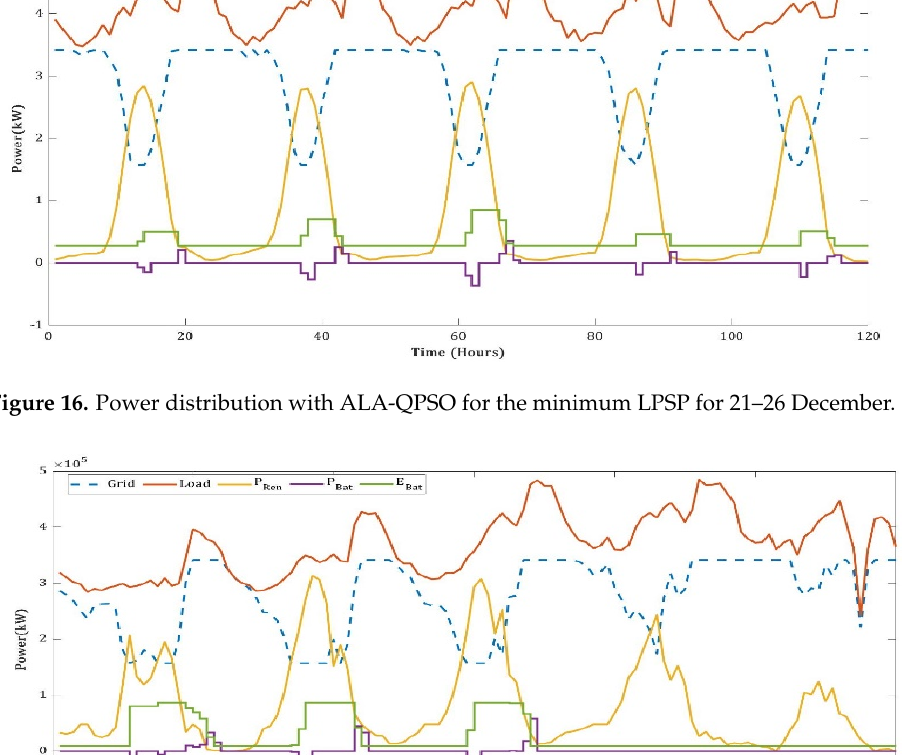
Figure 18. Power distribution with mutation-based ALA-QPSO for the minimum LCoE for 21–26 June. A sensitivity analysis is performed on the results obtained through ALA-QPSO. In the first scenario, it is assumed that there is 50% damage to the BESS. The power distri- bution with this scenario is shown in Figure 19 for June. It can be observed that the de- mand response is enforced during peak hours. It should be noted that the LCoE has in- creased drastically to 0.1372 USD, which is 73% more. In addition, the LPSP has increased to 1.62%. We conclude that preventive maintenance is necessary to avoid any load loss due to BESS reduction. Another sensitivity analysis is performed for 20% demand ap- preciation and 20% BESS reduction. The results for the same are shown in Figure 20. It is observed that due to the rise in demand, ramping rates of the grid are maxed out, and hence the BESS supports the grid during sunset, leading to less backup power for the peak time. It is observed that the LCoE has increased drastically to 0.1577 USD/kW, which is twice that of the actual, and the LPSP has increased to 1.85%. Further, in the case of reduced solar power, the BESS cannot compensate for the generation, even when the ramping is maxed out. It can be concluded that for reliable operation, the size of the BESS should be increased when the LCoE configuration is considered.